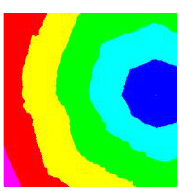
Figure 17. Hiking distance measurements for the corral site F26 on Jebel Bishri using GIS. The analysis executed by M. Törmä